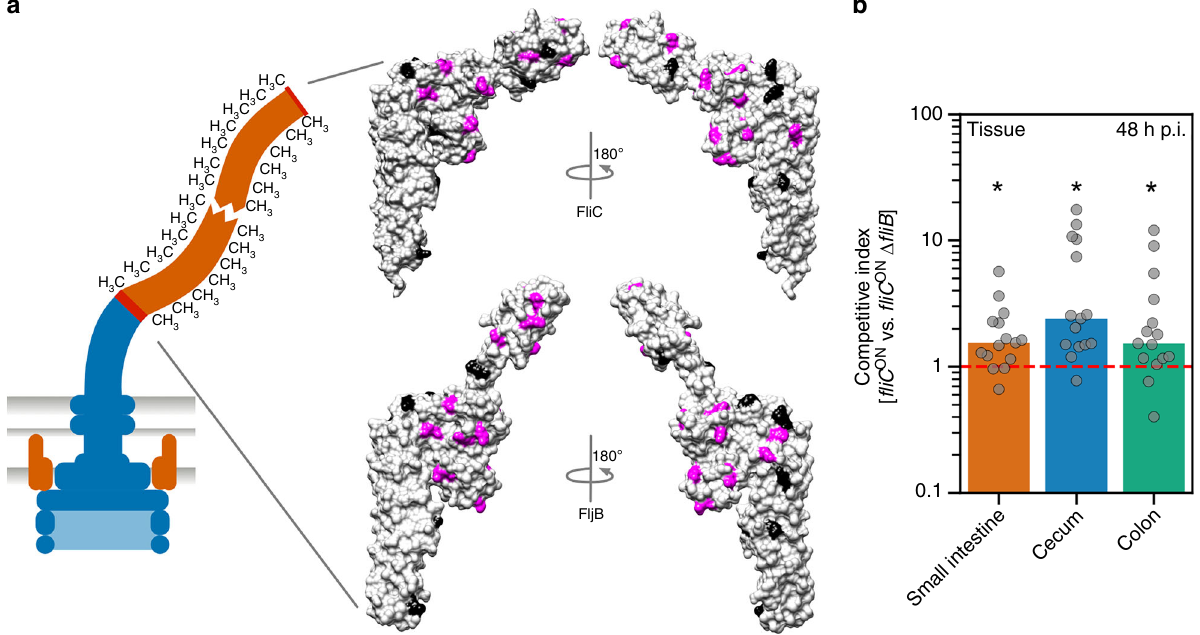
Fig. 2 Surface-exposed methylation of fl agellin contributes to ef fi cient colonization of the murine intestine. a Schematic of a methylated fl agellar fi lament and surface representation of the structure of FliC (top) and FljB (bottom). Methylation sites are highlighted in magenta and non-methylated lysines in black. b Streptomycin pre-treated C57BL/6 mice were infected with 10 7 CFU of the FliC-expressing WT ( fl iC ON ) and isogenic Δ fl iB mutant, each harboring a different antibiotic resistant cassette. The organ burden (small intestine, colon and cecum, respectively) was determined 2 days post-infection and used to calculate the competitive indices (CI). Each mouse is shown as an individual data point and signi fi cant differences were analyzed by a two-tailed Wilcoxon Signed Rank test. The bar graph represents the median of the data and asterisks indicate a signi fi cantly different phenotype to the value 1 (* = p < 0.05. WT vs. Δ fl iB small intestine: p = 0.0135, WT vs. Δ fl iB cecum : p = 0.010, WT vs. Δ fl iB colon : p = 0.0384). n = 15 biologically independent animals. Source data are provided as a Source Data fi